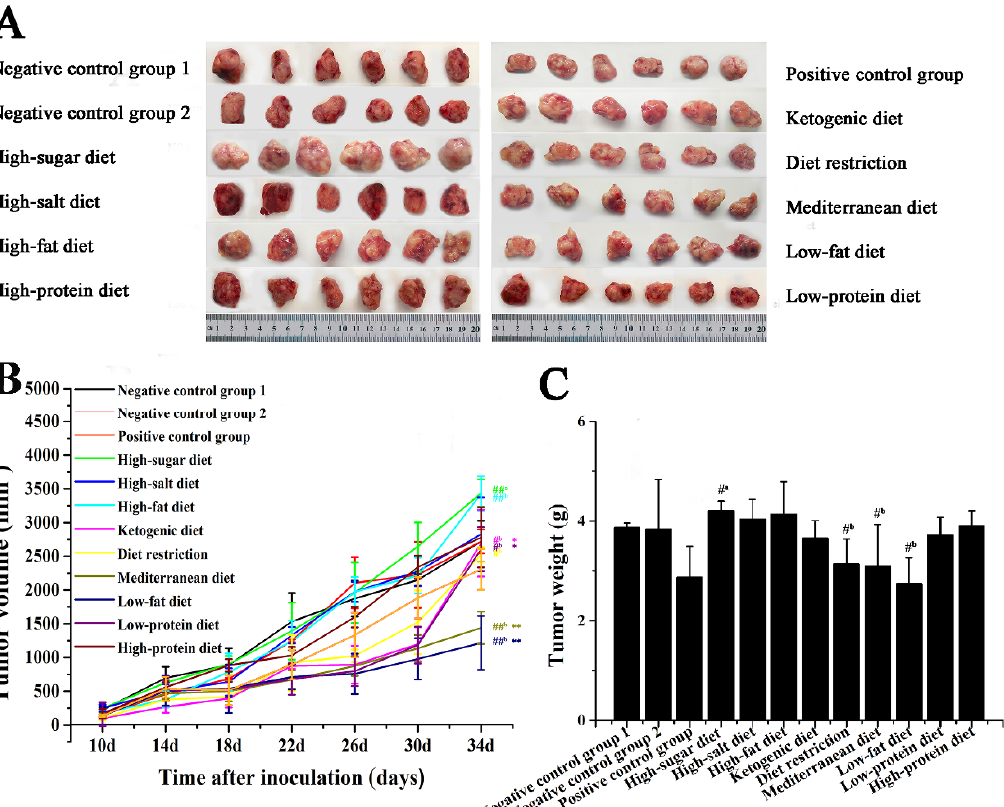
Figure 1. Effects of different dietary patterns on body weight. ( A ) Images of tumors in mice, n = 6. ( B ) Mice weights were recorded every 7 days. #b p < 0.05 and ##b p < 0.01 compared with negative control group 2.